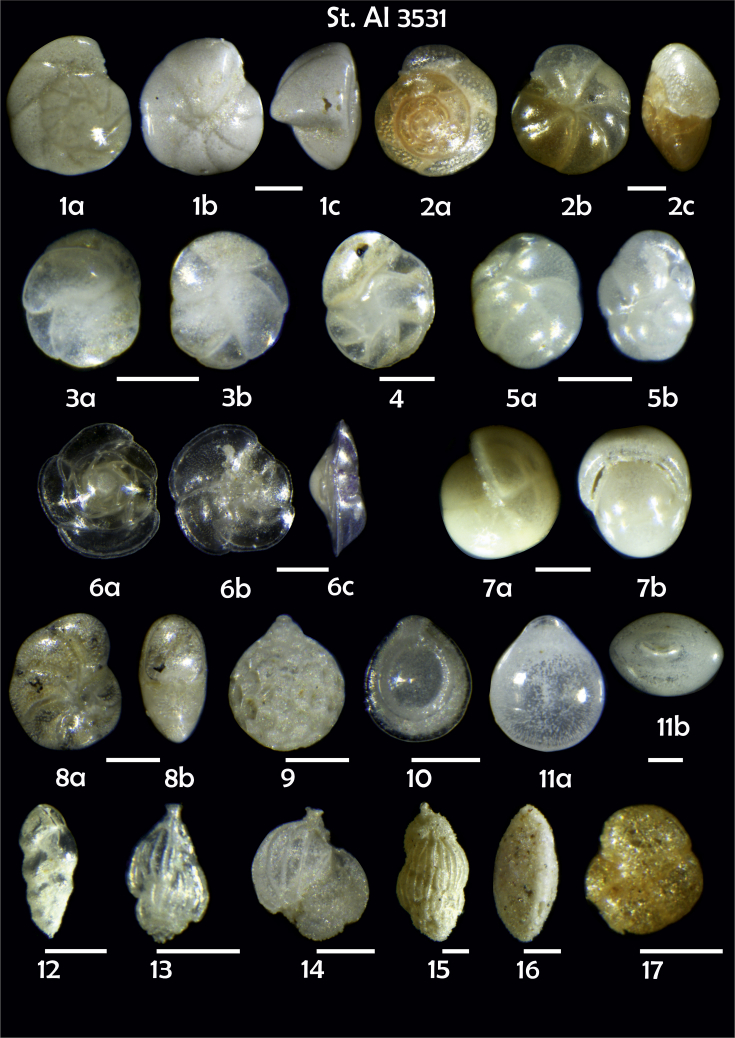
Station 35311Hansenisca soldanii,a spiral view, b umbilical view, c apertural view. 2Cibicidoides bradyi, a umbilical view, b spiral view, c apertural view. 3Cassidulina laevigata, a apertural view, b lateral view. 4C. teretis. 5Globocassidulina subglobosa, a, b apertural view. 6Gavelinopsis praegeri,a spiral view, b umbilical view, c lateral view. 7Pullenia bulloides, a side view, b apertural view. 8Elphidium excavatum, a, b side view. 9Oolina squamosa. 10, 11Fissurina spp., a side view, b apertural view. 12Brizalina subspinescens.13, 14Trifarina angulosa. 15Uvigerina peregrina. 16Sigmoilopsis schlumbergeri. 17Trochammina inflata. Scale 100 μm.